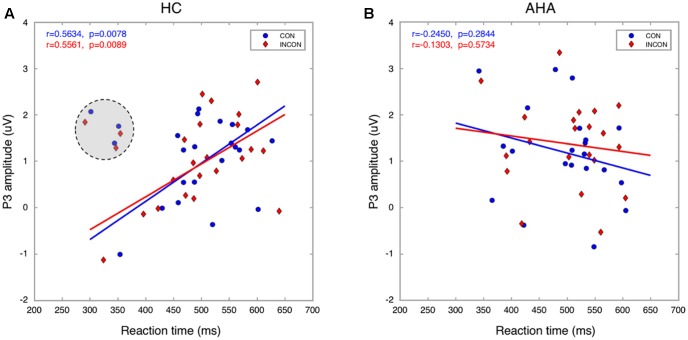
Relationship between P3 amplitude and RT. The P3 amplitude is significantly correlated with RT in both congruent and incongruent conditions for HCs (A). In contrast, it was anticorrelated with RT for AHAs (B). Three HCs (marked with a gray shadowed circle) were excluded from the analysis as they were considered outliers.